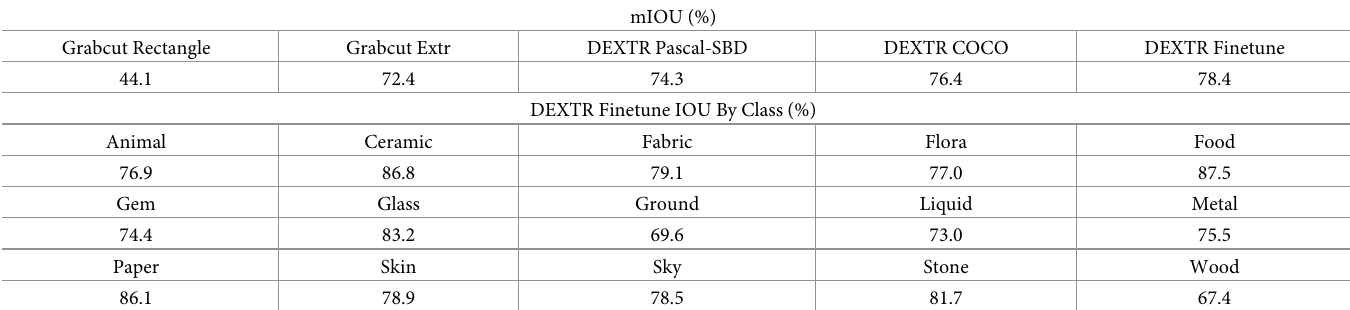
Table 3. Segmentations from extreme clicks. Grabcut [101] rectangles use bounding-box only initialization as a reference baseline. Grabcut Extr is based on the improved GC initialization from [88] with small modifications: (a) we compute the minimum cost boundary with the cost as the negative log probability of a pixel belonging to an edge; (b) in addition to clamping the morphological skeleton, we also clamp the extreme points centroid as well as the extreme points; (c) we compute the GC directly on the RGB image. DEXTR [98] Pascal-SBD and COCO are pretrained DEXTR ResNet101 models on the respective datasets. Note that Pascal-SBD and COCO are natural image datasets of objects, but DEXTR transfers surprisingly well across both visual domains (paintings vs. photos) and annotation categories (materials vs. objects).